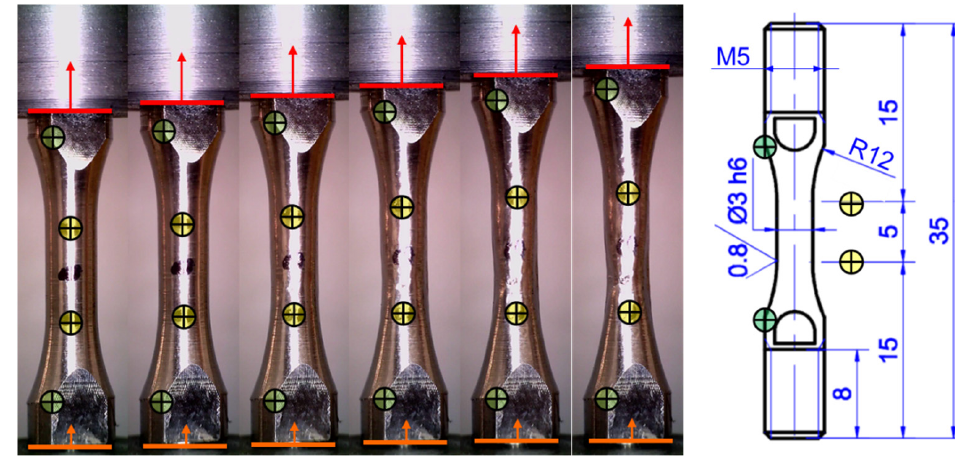
Figure 1. Scheme of the digital image analysis for the evaluation of deformation.